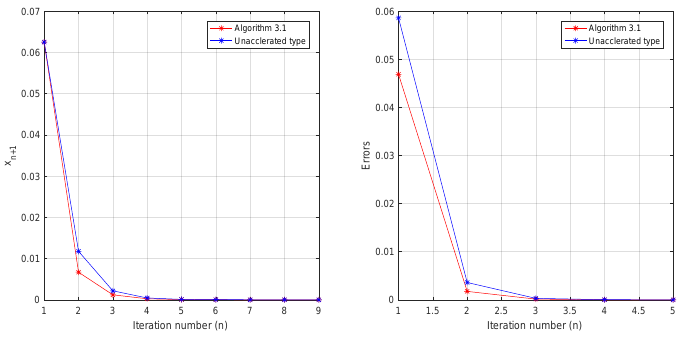
Algorithm 3.1 Unacclerated type